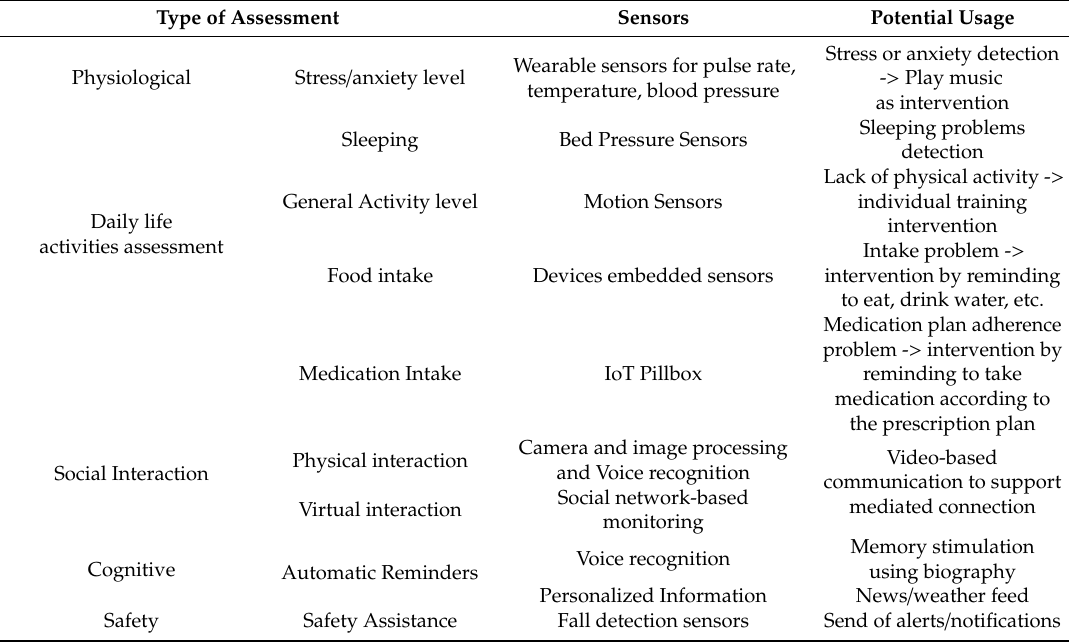
Table 2. Potential usage of